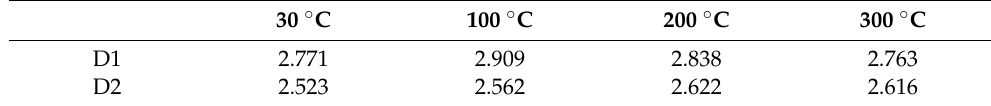
Figure 9. Fractal dimension fitting curve after different temperature treatments. D1 and D2 are obtained from the fractal dimension fitting curve of Figure 9, where D1 is the fractal dimension of the high-pressure segment, that is, the fractal dimension of the pore structure. D2 is the fractal dimension of the low-pressure segment, that is, the fractal dimension of the pore surface. In Table 3, fractal dimensions of different pore sizes are obtained by different temperature treatments. Table 3. Fractal dimensions after different temperature